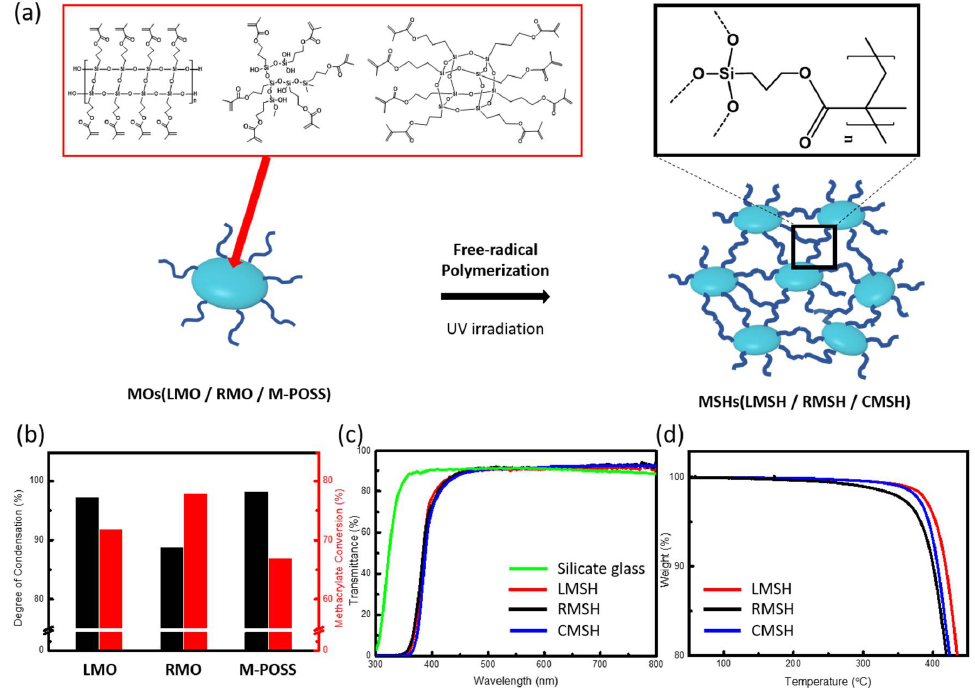
Figure 3. ( a ) Fabrication scheme of the methacrylate siloxane hybrid materials (LMSH, RMSH, and CMSH) with free-radical polymerization of methacrylate oligo-siloxane resins (LMO, RMO, and M-POSS); ( b ) Degree of condensation (black bar) and methacrylate conversion (red bar) of the resins; ( c ) Total transmittance of 1 mm bulks in the range of 300–800 nm and comparison of